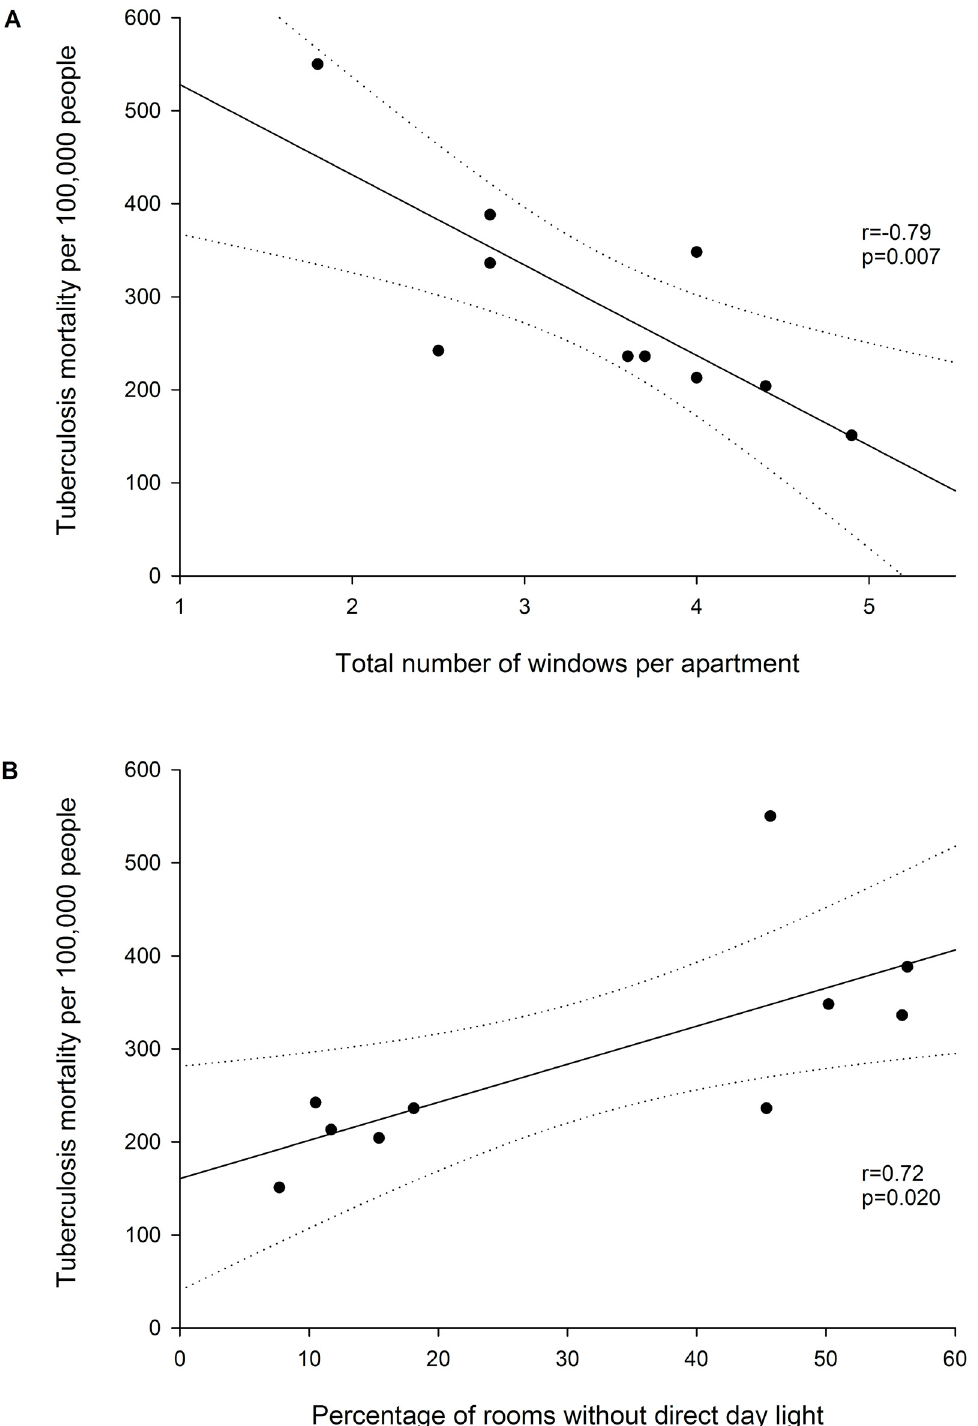
Fig 3. Correlation between TB mortality according the total number of windows per apartment (Fig A) and the percentage of rooms without direct day light (Fig B) in the ten quarters of Bern, 1911 – 1915.